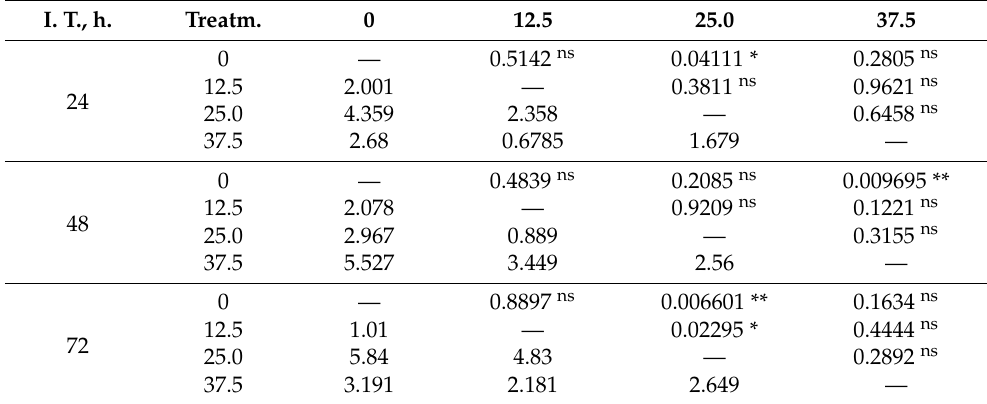
Table 6. Comparison of means of germination velocity coefficient (GVC) with 24, 48, and 72 h of immersion in Biozyme ® TS (gibberellins), according to Tukey HSD.